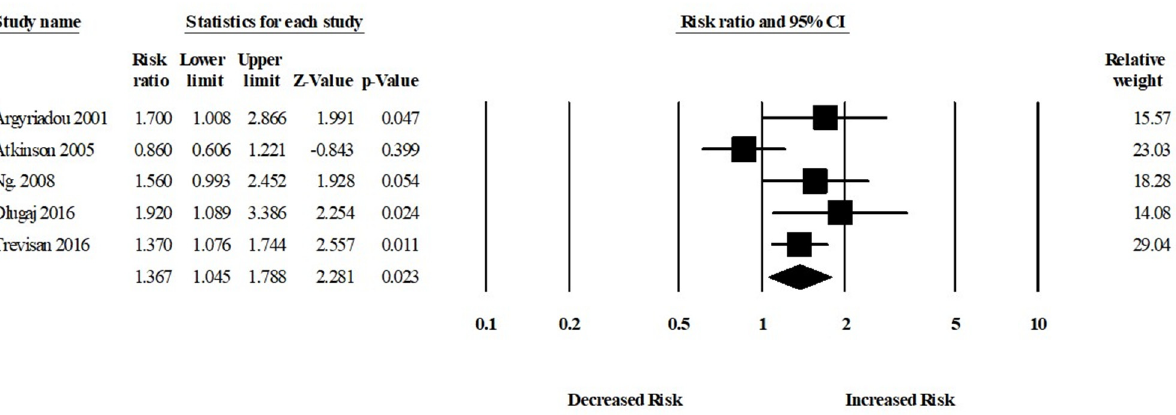
Figure 5. Association between anemia and mild cognitive impairment [6,20,22,30,31].